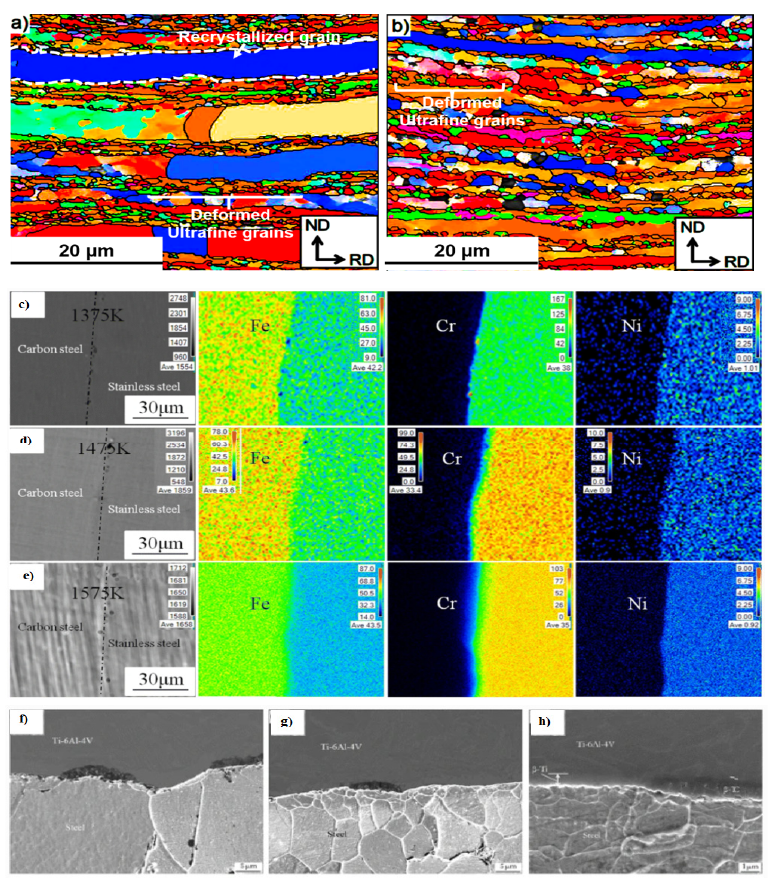
Figure 5. Microstructure evolution in Al2N/Al5N composite joint ( a ) after 8 ARB cycles (where white dashed line is showing one of the recrystallized grains with the presence of deformed UFGs), and ( b ) after 10 ARB cycles, where recrystallization is absent, adapted from Ref. [53]. ( c – e ) HRB macrostructure and elemental maps showing the interfacial alloying elements maps of stainless-steel clad plates rolled at different temperatures adapted from Ref. [54]. ( f – h ) Microstructure of dissimilar hot-roll-bonded interface at 1050 °C at 36, 58, 70% reduction ratio, adapted from Ref. [55].